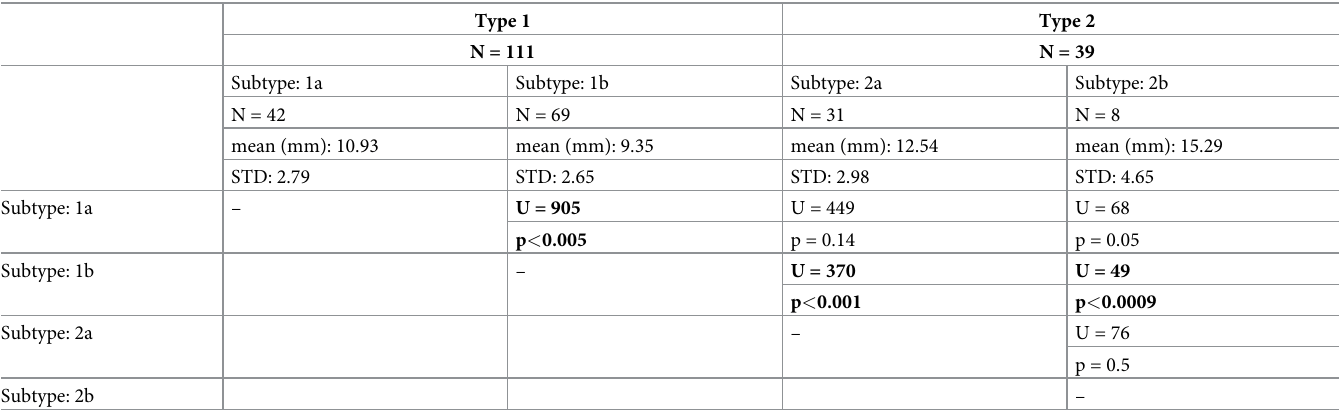
Table 2. Significance test results for the rim’s curve among the subtypes.